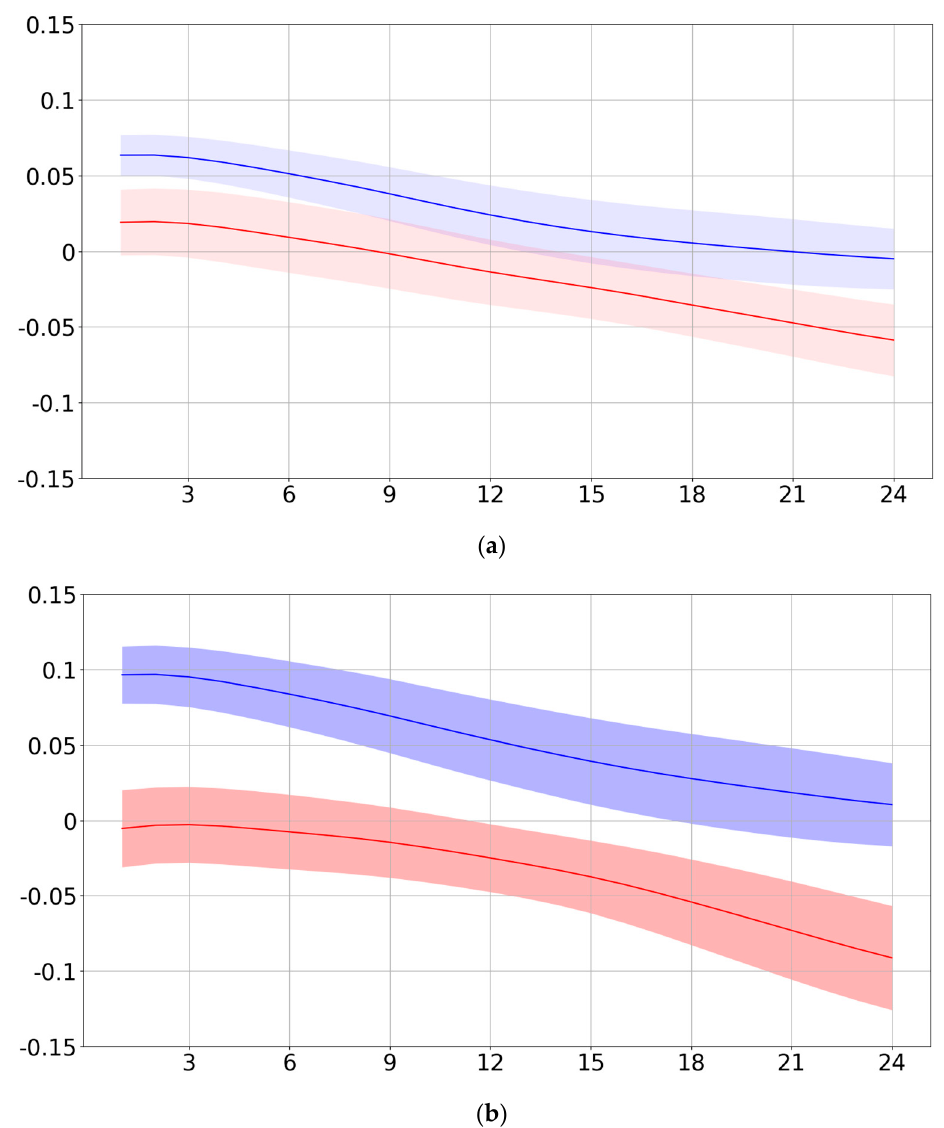
Figure 3. Conditional impulse response of interest rates after the global financial crisis. ( a ) Based on Korea Real Estate Board Price Index, ( b ) based on KB Price Index. Note 1: the horizontal axis represents the impulse response period (months), and the vertical axis represents the response (%) to a 0.25% interest rate shock. Note 2: In the graph, blue indicates the impulse response during a period of falling interest rates and red the response during a period of rising interest rates. Source: estimated by authors.